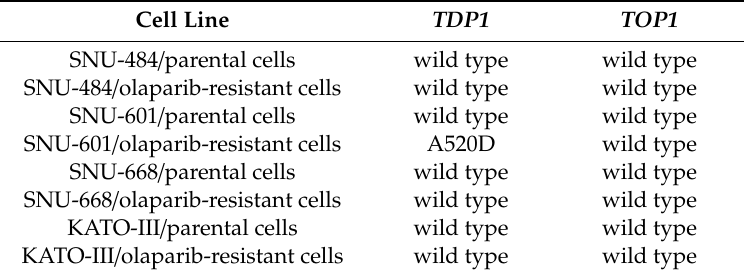
Table 2. Mutation status for TDP1 and TOP1 in parental and olaparib-resistant